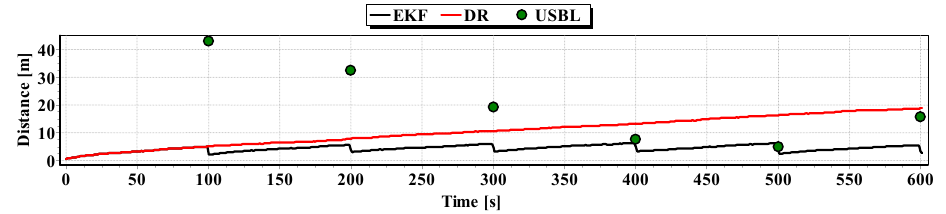
Figure 31. Graph of the reference position distance from the position estimated by EKF and DR methods and determined by the USBL system (one hundred passages).